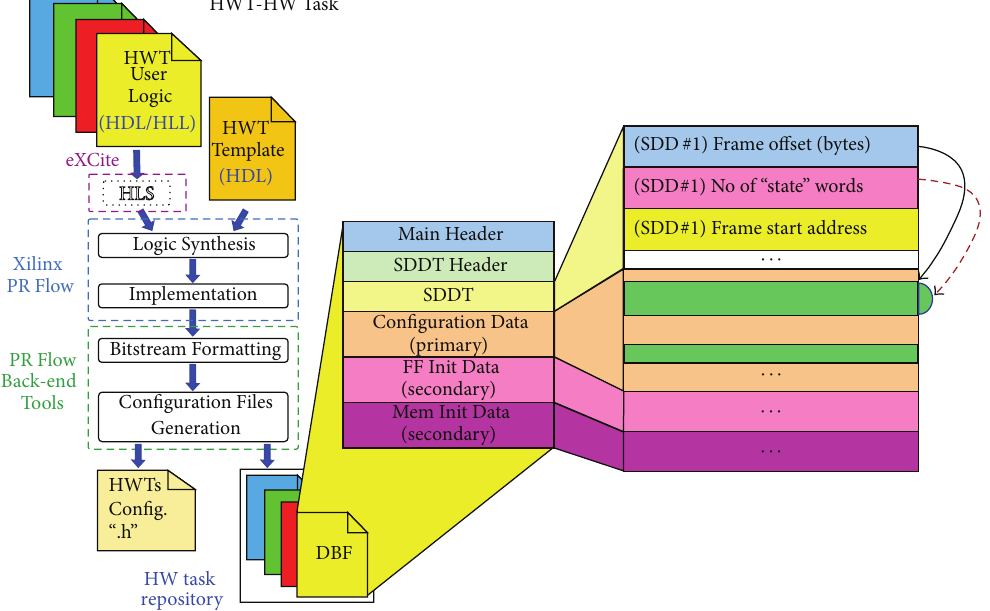
Figure 5: DBF file